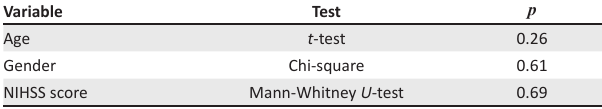
TABLE 1: Mean comparison tests between drop out and nondrop out groups.